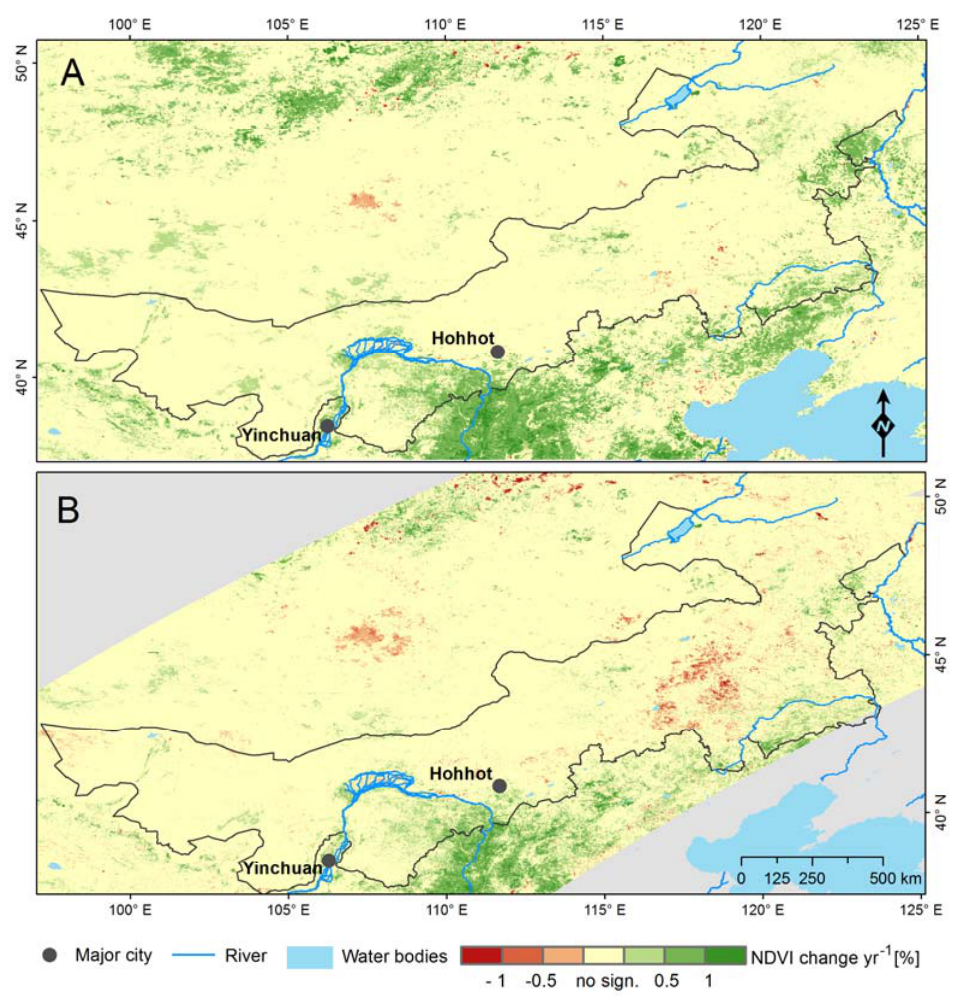
Figure 3. Maps of Normalized Difference Vegetation Index (NDVI) change between 2001 and 2010 based on statistically significant Sen’s slope of 1-km SPOT VGT ( A ) and 250-m MODIS ( B ) time series ( p < 0.05, MSK test). Comparison of Sen’s slope values for different phenological parameters based on 2770 sampling plots ( C